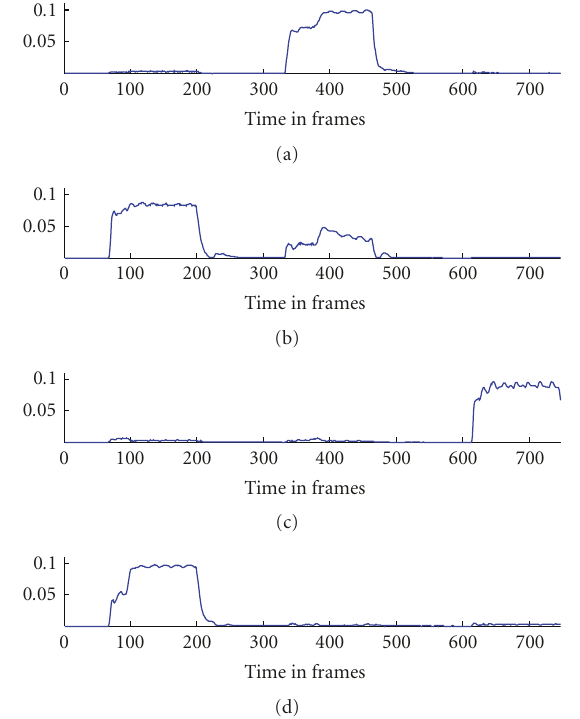
Figure 5: The visualisation of row vectors of the matrix H o for rank R = 4.